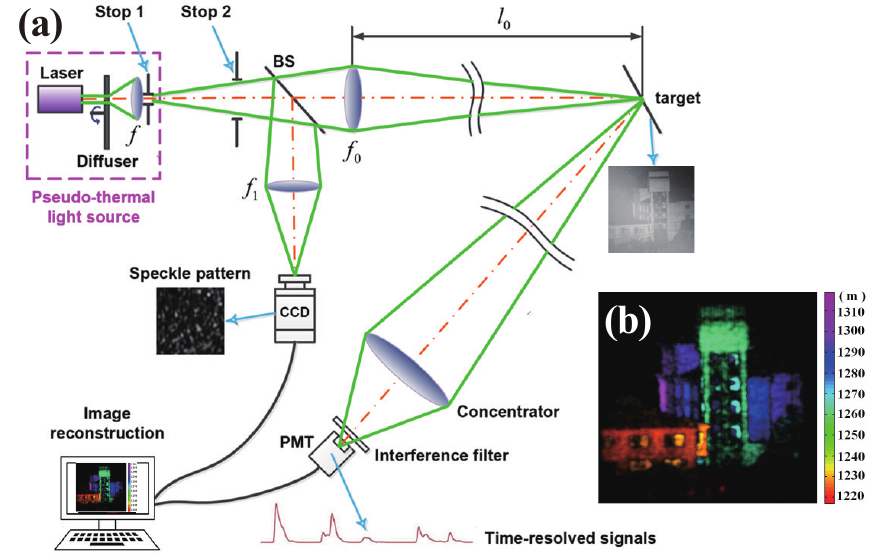
Figure 1. ( a ) Schematic of GISC LiDAR system. BS: beam splitter; CCD: charge-coupled device; PMT: photomultiplier tube. ( b ) 3D GISC reconstruction of a static scene at about 1.2 km far away